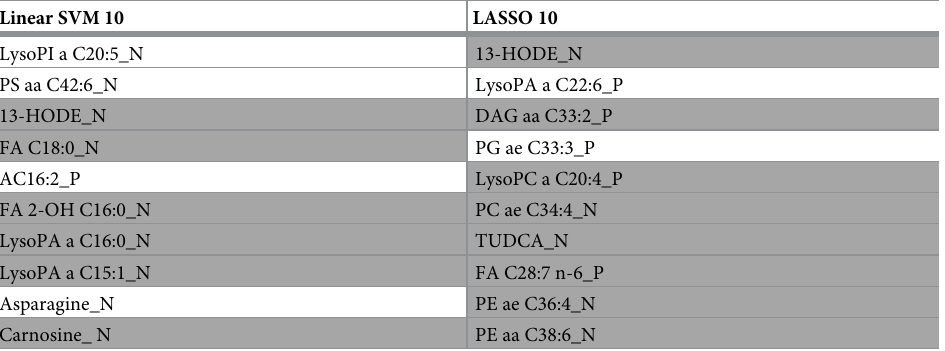
Table 3. Discrepant best preliminary analyte panels between athlete and external cohorts. Linear SVM 10